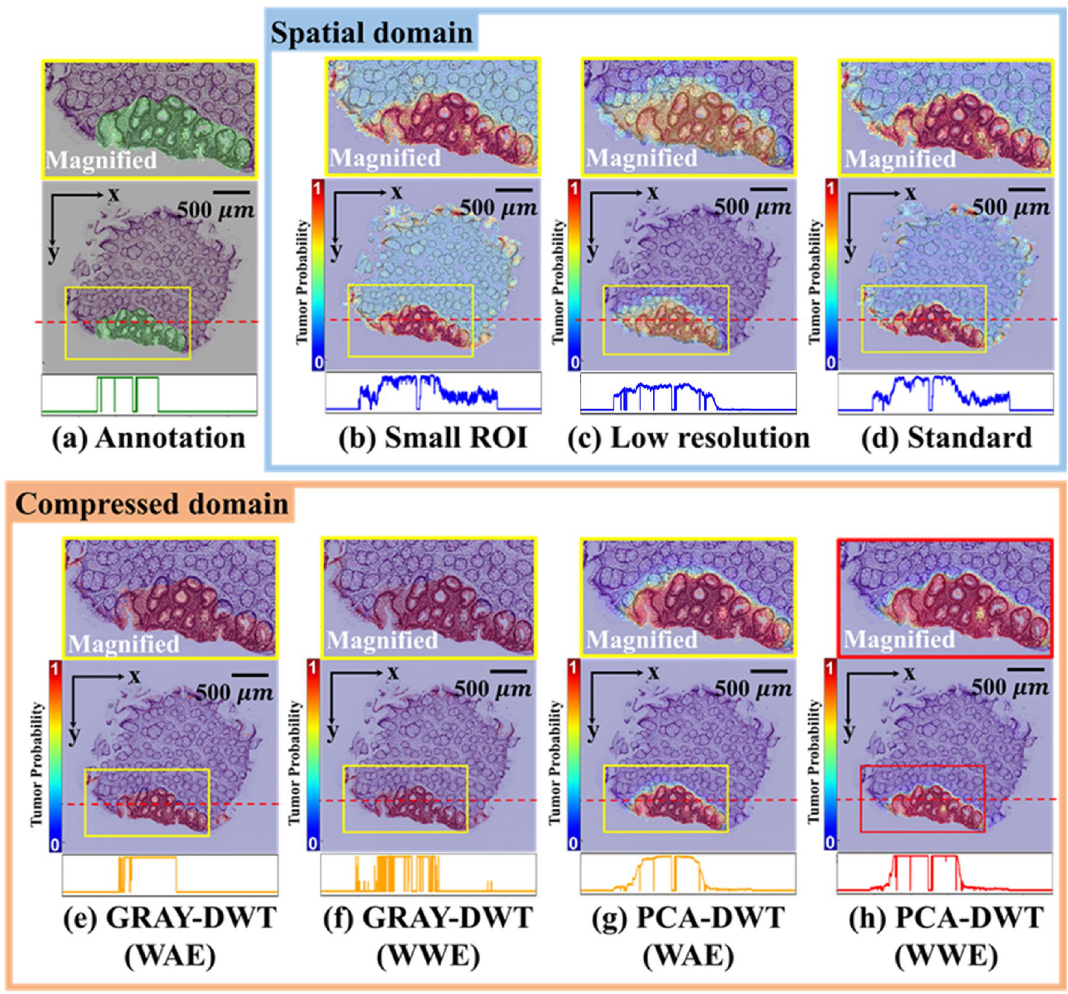
Figure 3. ( a ) Annotation: Annotated image, corresponding magnified image (above), and Dashed red line profiles (below). ( b ) Small ROI: The result of small ROI input in spatial domain (Tile size: 256 by 256, ×20 magnification). ( c ) Low resolution: The result of low-resolution input in spatial domain (Tile size: 512 by 512, ×10 magnification). ( d ) Standard: The result of standard input in spatial domain (Tile size: 512 by 512, ×20 magnification). ( e ) GRAY-DWT (WAE): The result of weighted average ensemble (WAE) result for wavelet sub-band after grayscale conversion. ( f ) GRAY-DWT (WWE): The result of wavelet weighted ensemble (WWE) result for wavelet sub-band after grayscale conversion. ( g ) PCA-DWT (WAE): The result of weighted average ensemble (WAE) result for wavelet sub-band after principle component analysis (PCA). ( f ) PCA-DWT (WWE): The result of wavelet weighted ensemble (WWE) result for wavelet sub-band after principal component analysis probability line profile processed with PCA-DWT (WWE) is most similar to the original annotation profile, proving the accuracy of our method. Average dice for each method according to the threshold. The Dice scores for the result in spatial domain are compared across a range of threshold tumor probability values (Fig. 4a), and WWE for the wavelet sub-bands after PCA or grayscale conversion, WAE for the wavelet sub-bands after PCA or grayscale conver- sion (Fig. 4b). Between threshold values of 0.1 and 0.6, the Dice score of the result in spatial domain is relatively stable. However, beyond a threshold of 0.7, the Dice score for this method drops sharply, compared to those of the other methods. WAE and WWE continue perform robustly for all thresholds, and the Dice score of WWE is consistently higher than that of WAE, thanks to the high-frequency information. Final prediction result of five different tumor classes using PCA‑DWT (WWE). Finally, we com- pared our PCA-DWT (WWE) predicted image with the image annotated by a pathologist. Figure 5a–e shows tissue histology images from five different tumor categories. The pathologist’s annotations are shown in Fig. 5f–j. The corresponding predicted probability map using PCA-DWT (WWE) are shown in Fig. 5k–o and final over- laid tissue images are shown in Fig. 5p–t. The proposed PCA-DWT (WWE) method generally segmented an